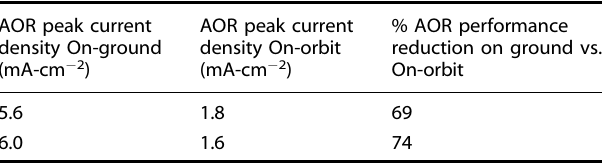
Table 1. Ammonia oxidation reaction (AOR) peak current density generated and % performance reduction on ISS orbit compared to ground conditions.